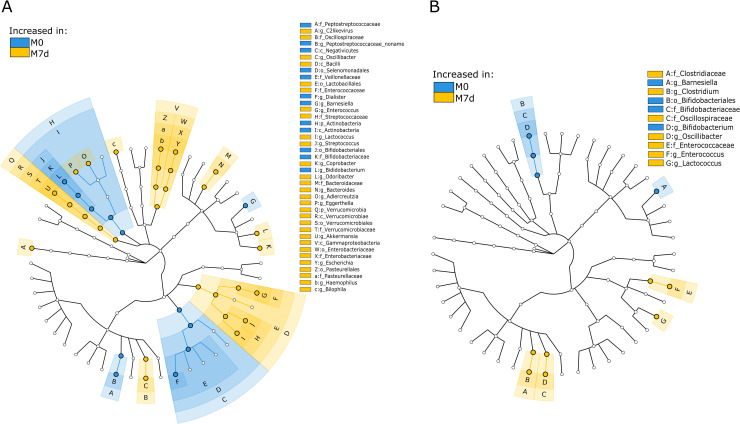
GraPhlAn cladogram for taxonomic composition changes during a week-long metformin administration.(A) healthy individuals, (B) type 2 diabetes patients. Samples are marked as follows: M0—before starting metformin treatment (blue); M7d –after 7 days treatment with metformin (yellow). Colors of nodes and shading indicate the microbial lineages that are enriched within corresponding samples. Only differentially abundant taxa at the genus or higher taxonomic ranks are indicated. For detailed results in lower taxonomical levels, see S1 and S2 Figs.